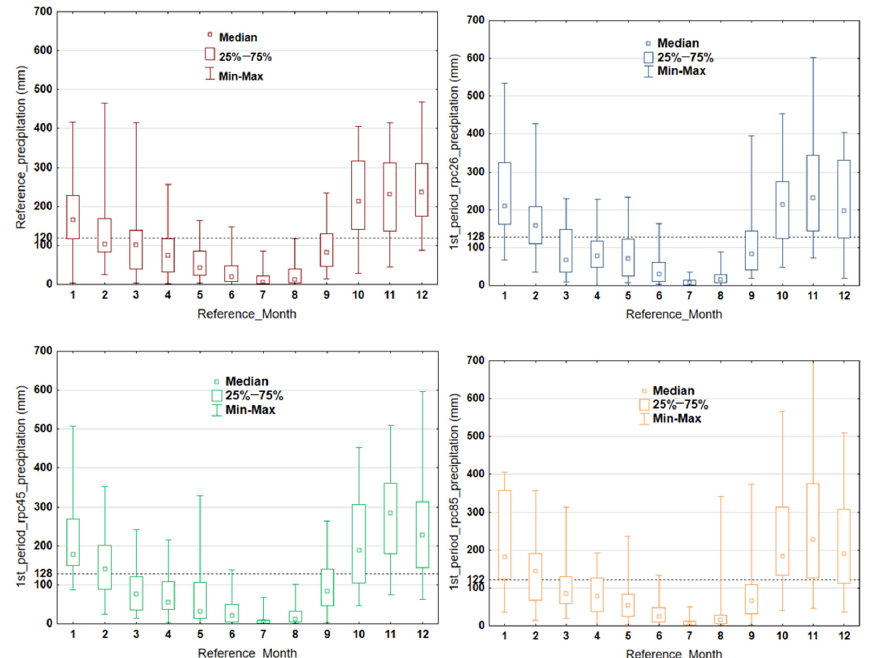
Figure 9. Distribution of the variations in the maximum monthly precipitation values for the reference period and the first-period climate scenarios (2031–2060). Dashed lines are the average values of the projected data.